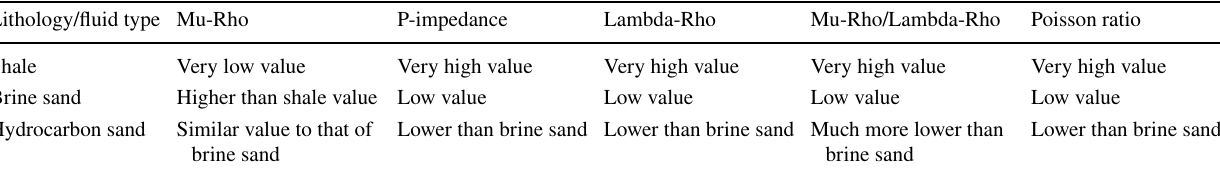
Fig. 4 Synthetic correlation, relative error and P-impedance error for the six wells available for inversion Table 1 Summary of rock properties for lithology and fluid discrimination ( Omudu and Ebeniro 2005) Lithology/fluid type